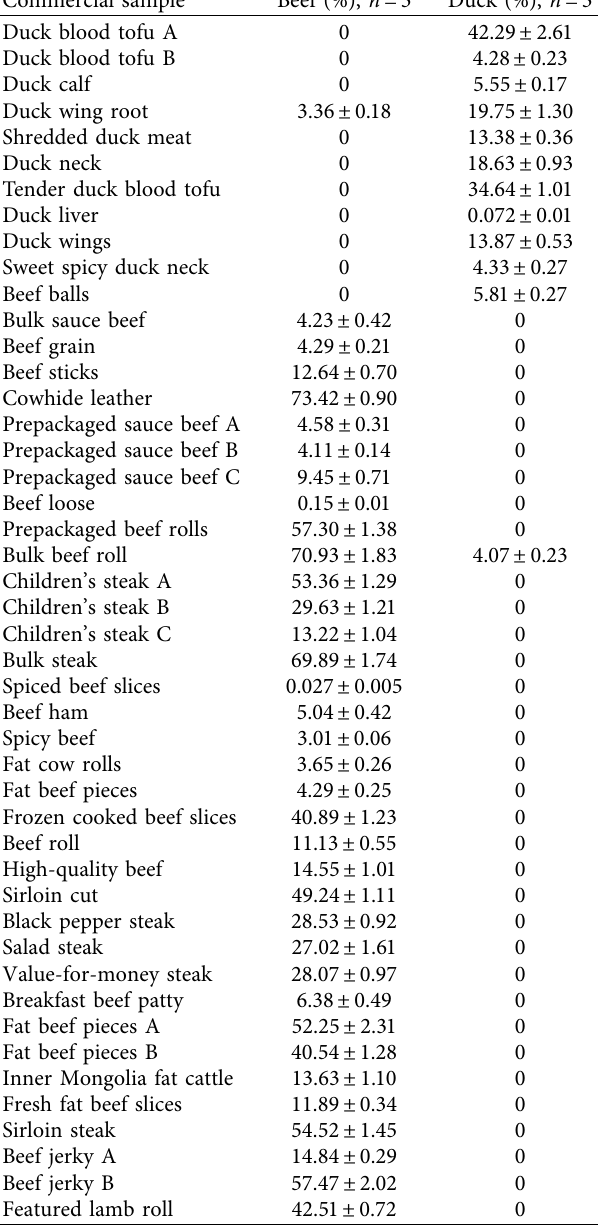
Table 4: Adulteration detection of commercial samples. Commercial